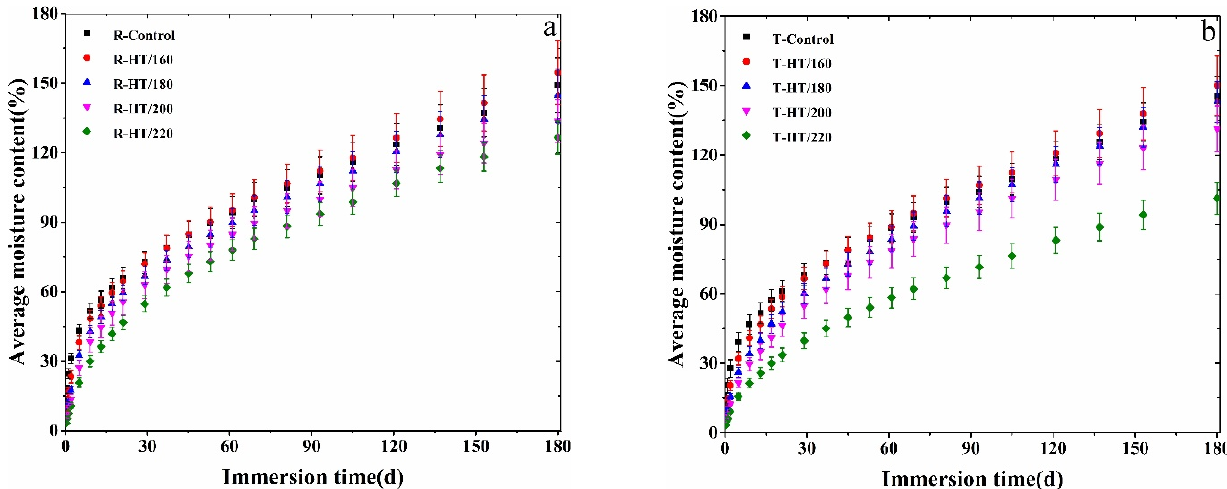
Figure 1. The change of average MC along with the immersion time for the references and heat-treated samples (( a ) water absorption in the R-direction, ( b ) water absorption in the T-direction).